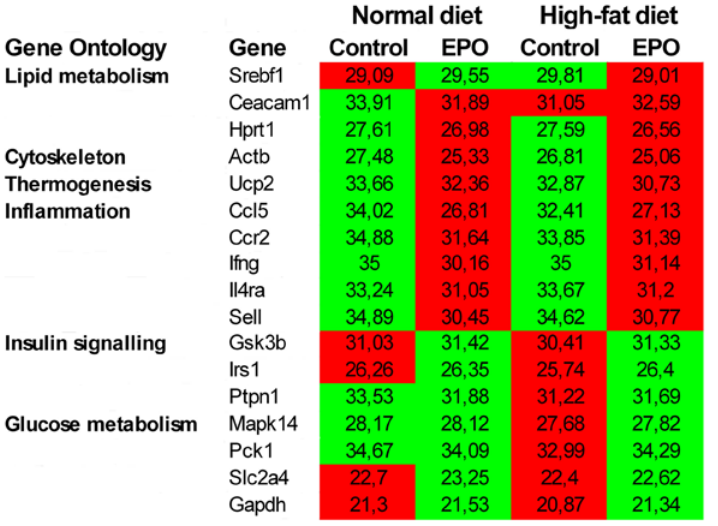
Figure 5. EPO induced changes in muscle gene expression one week after electrotransfer. Significantly differentially expressed genes are depicted according to gene ontology groups. Control and EPO transfected groups were fed either a normal chow or a high-fat diet for one week. Mean Ct threshold is depicted foreach group andredcorresponds to a high expression value; green indicates a lowerexpression value (n=4–5in each group). doi:10.1371/journal.pone.0005894.g005 PLoS ONE |